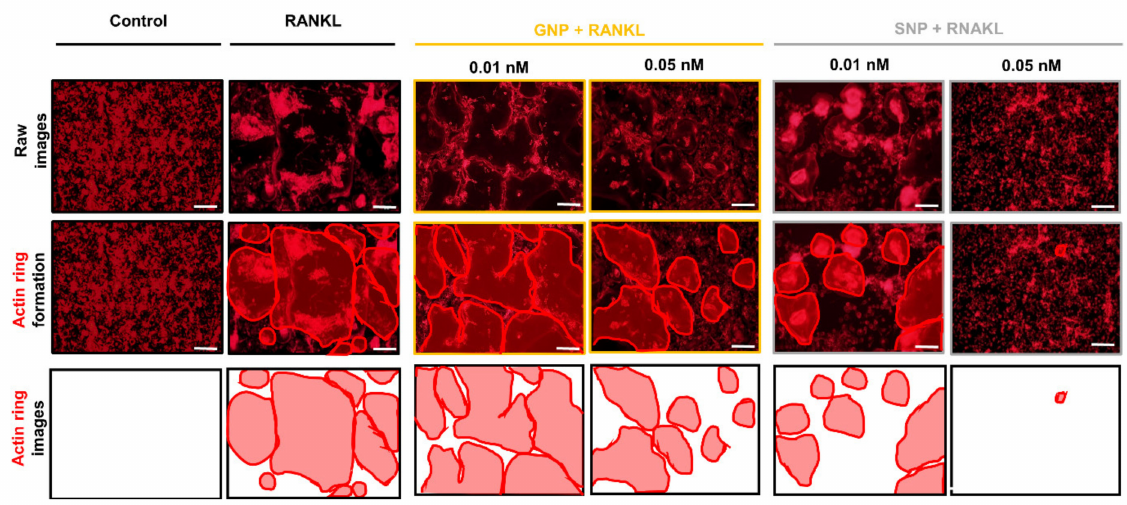
Figure 3. RANKL-induced tartrate-resistant acid phosphatase (TRAP) assay outcomes with GNPs or SNPs. BMMs were differentiated into osteoclasts with a complete culture medium (CCM, with RANKL medium) for five days. ( A ) BMMs of the control group were cultured with CM. BMMs of the RANKL group were cultured with CCM (without GNPs and SNPs). Scale bars: 200 µ m. ( B ) TRAP+ multinuclear cells (MNCs) were stained at various concentrations of GNPs or SNPs. Scale bars: 200 µ m. ( C ) The TRAP+ MNCs were quantified. The results are expressed as the mean ± SD ( n = 6 per group). “***” indicates a significant difference for which p < 0.001.